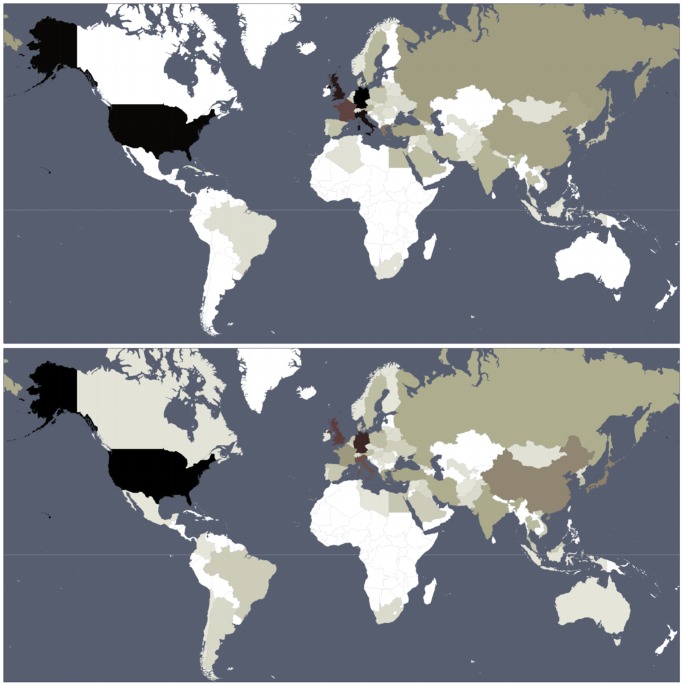
Sum of appearances of historical figures from a given country in the 24 lists of top 100 persons for PageRank (top panel) and 2DRank (bottom panel).Color changes from zero (white) to maximum (black). Maximal values are 233 appearances for Germany (top) and 236 for USA (bottom). Values are proportional to the averages per country shown in Fig. 1.